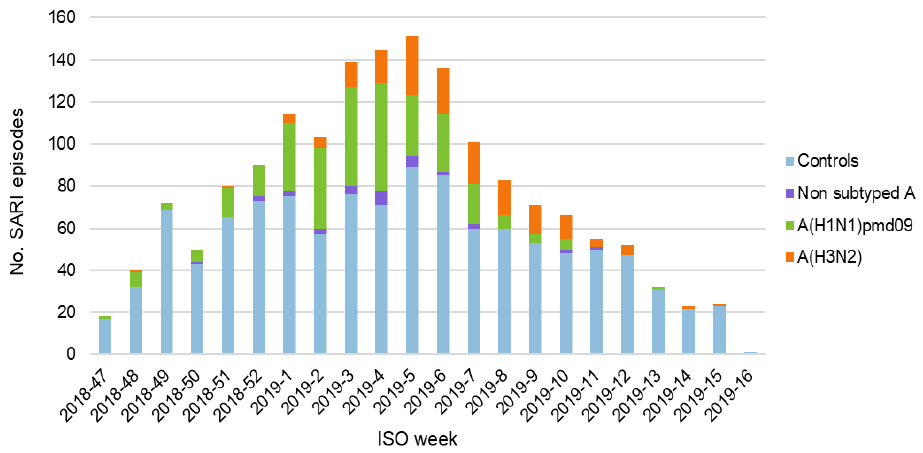
Figure 1. Episodes of severe acute respiratory infection (SARI) per week, stratified by cases/controls and influenza subtype.